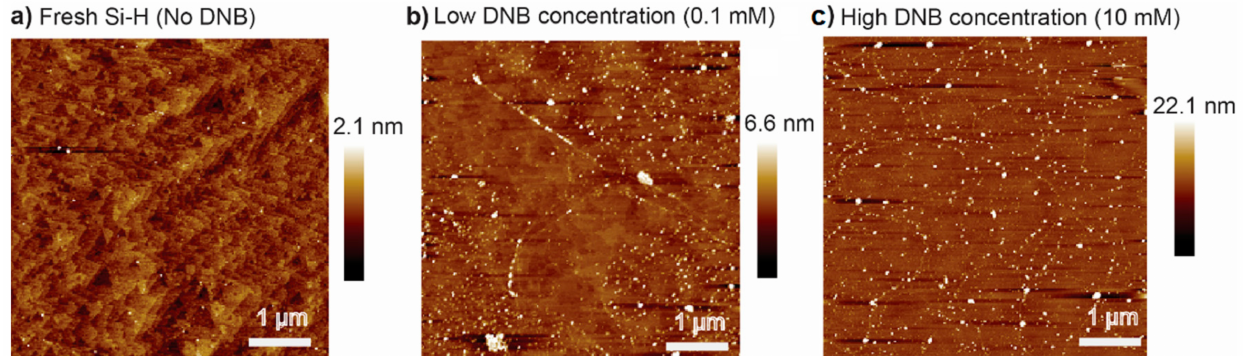
Figure 2. AFM topography images for the Si–H surface before and after DNB reduction. ( a ) AFM image for a freshly etched Si–H surface, showing flat Si terraces. ( b ) AFM image for a Si–H surface in DNB solution of 0.1 mM, showing that the surface is partially covered with a molecular film where in some areas the Si terraces are visible and in other areas the surface is covered with a molecular film. ( c ) AFM image for a Si–H surface in 10 mM DNB solution, showing the formation of a thicker molecular film that completely shadows the Si